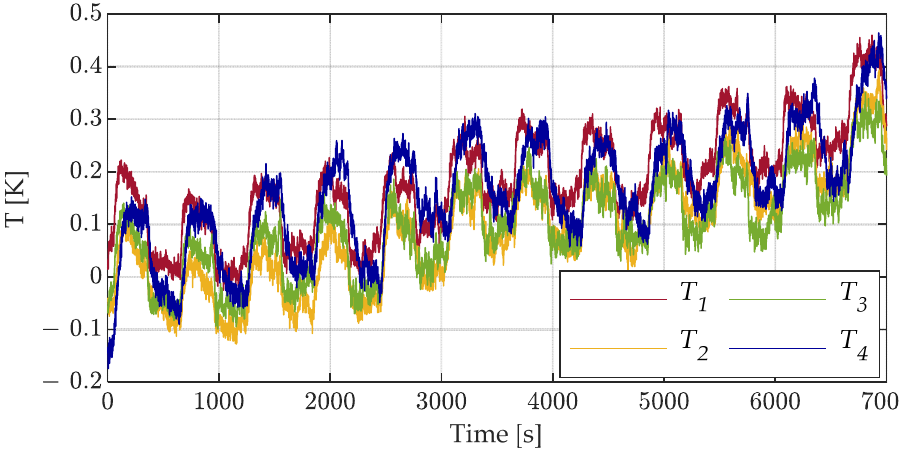
Figure 12. Error test single cell 10 A.